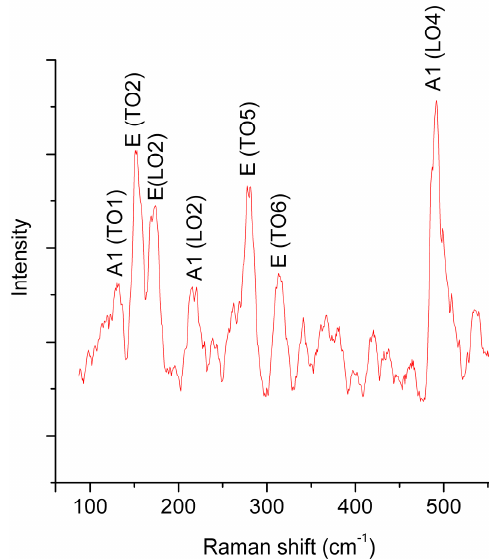
Figure 2. Raman spectra of the self-organized Bi-Fe-O film at the highly oriented pyrolytic graphite (HOPG) substrate.